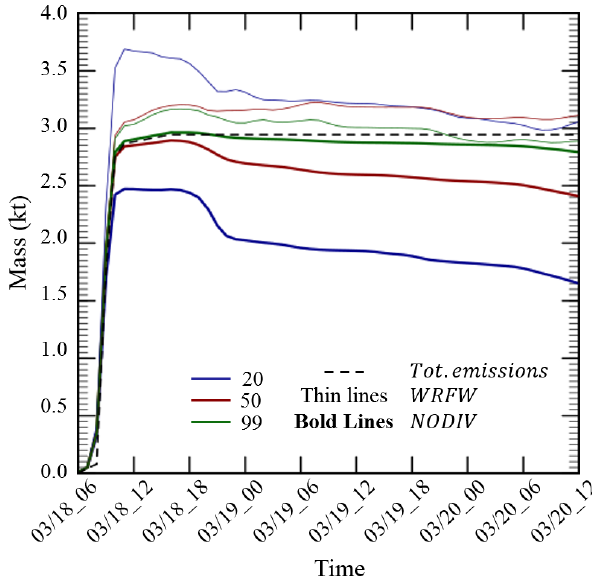
Figure 3. The SO 2 mass evolution in model domain (kilotons). The line color indicates the vertical level configuration, and the line thickness indicates the vertical wind strategy considered. The dotted line represents the cumulative SO 2 mass emitted during the Mount Etna